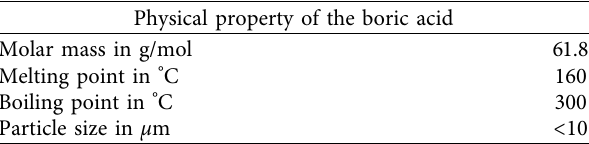
Table 4: Physical properties of the boric